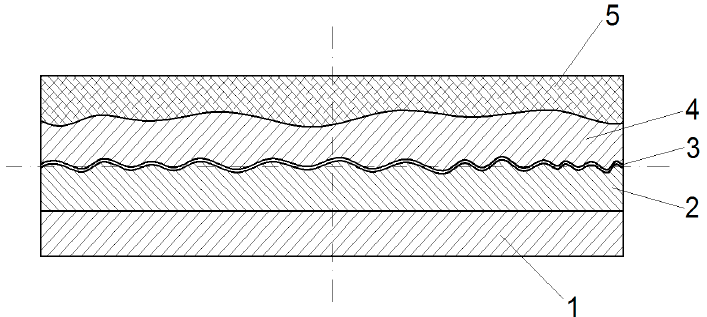
Figure 1. The main scheme to obtain ornamental synthetic plates [44]: 1—Mold support plate from glass fiber-reinforced polymer (GFRP); 2—Silicon rubber mold; 3—Release agent layer (polyvinyl alcohol, PVA); 4—Polyester resin with CaCO 3 ; 5—Structural composite material: polyester resin, sand, and fiber glass waste.